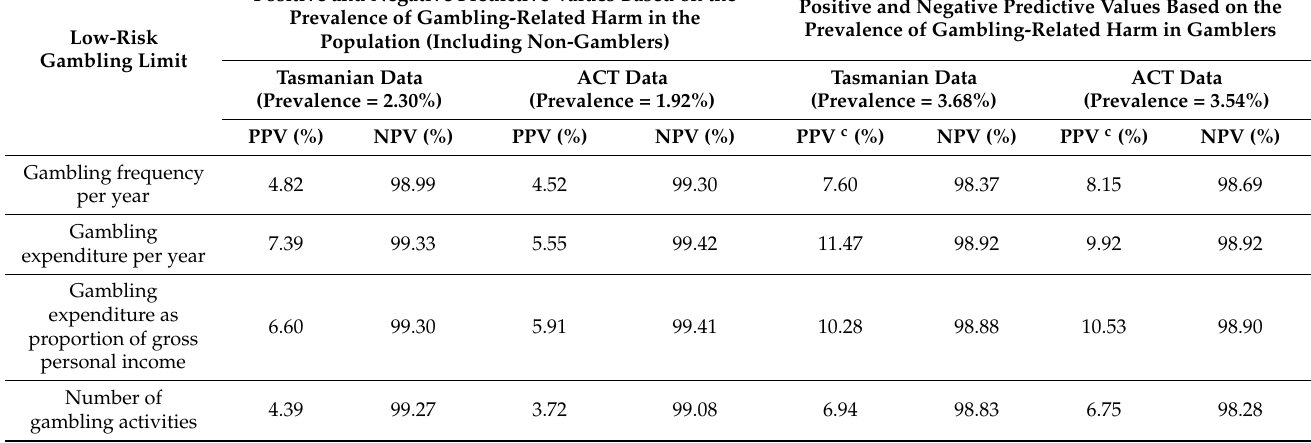
Table 5. Positive and negative predictive values based on the prevalence of gambling-related harm in the population and gambling samples a,b .